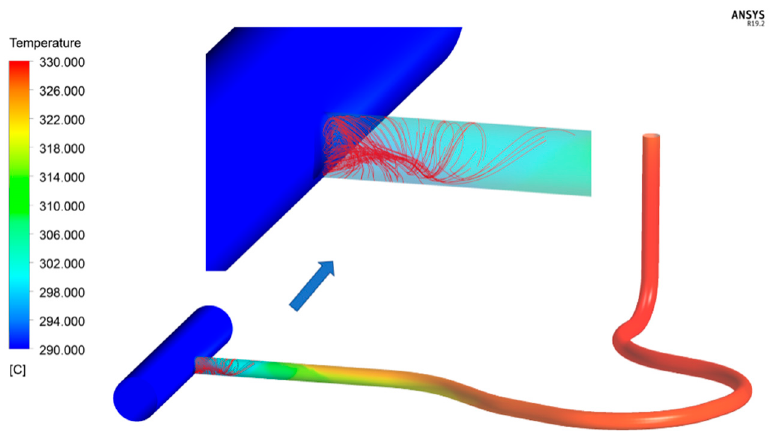
Figure 4. The streamline of the turbulent penetration region.